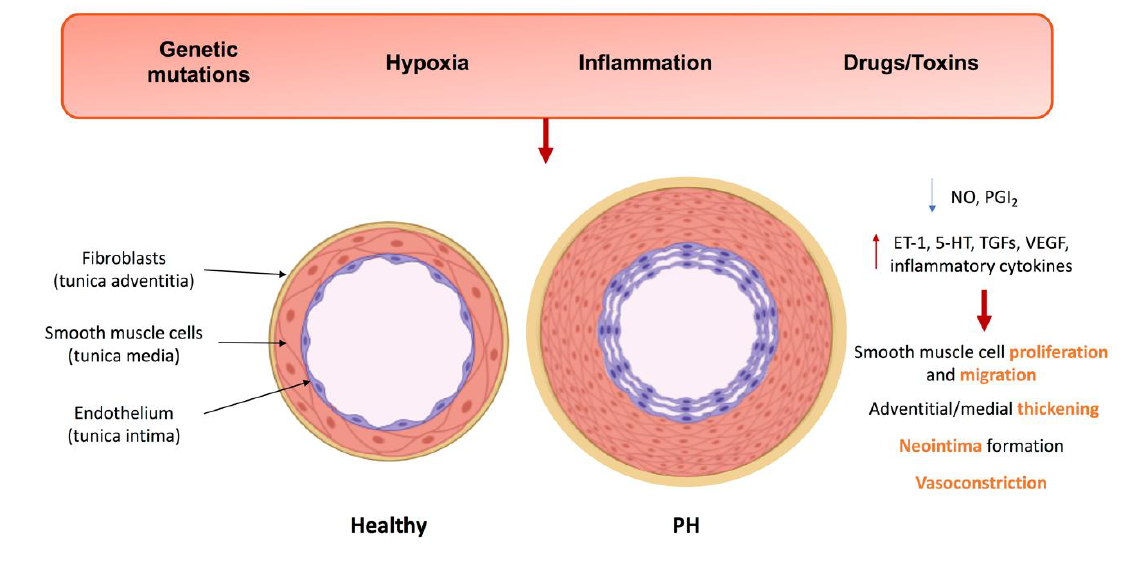
Figure 2. Abnormal vascular remodelling in pulmonary arterial